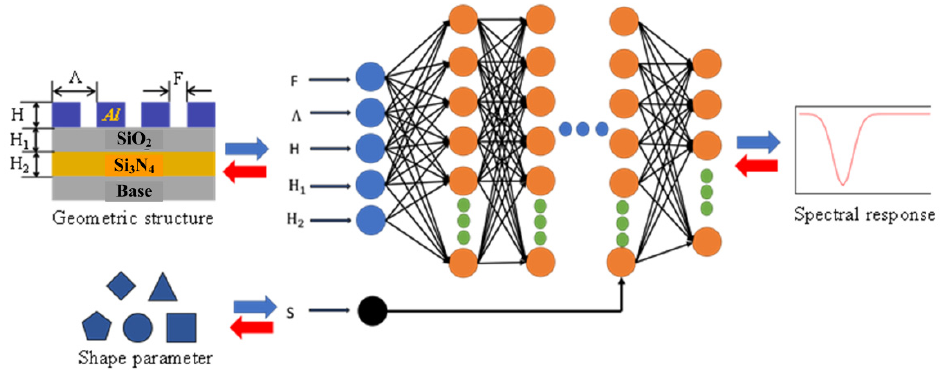
Figure 4. Schematic diagram of the two-dimensional sub-wavelength grating design neural net-